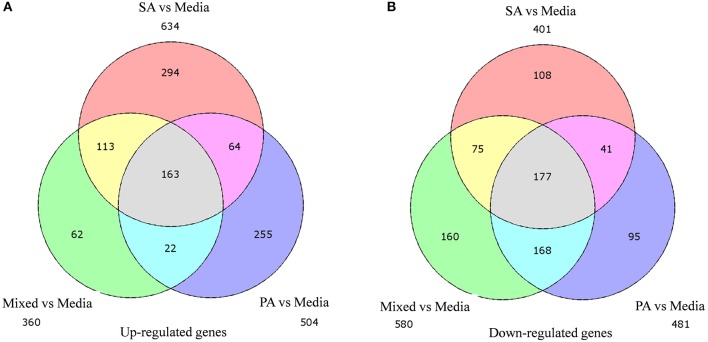
Venn diagram illustrating the number of genes commonly or uniquely differentially expressed in rat middle ear mucosa colonized with methicillin-resistant Staphylococcus aureus (MRSA) or Pseudomonas aeruginosa (PA) as a single species or multi-species inoculum. (A) Venn diagram showing significantly (p < 0.05) upregulated genes after colonization with MRSA, PA, or a combination of the two, with respect to the media (control). (B) Venn diagram showing significantly (p < 0.05) downregulated genes after MRSA, PA, or multi-species colonization, with respect to media control.